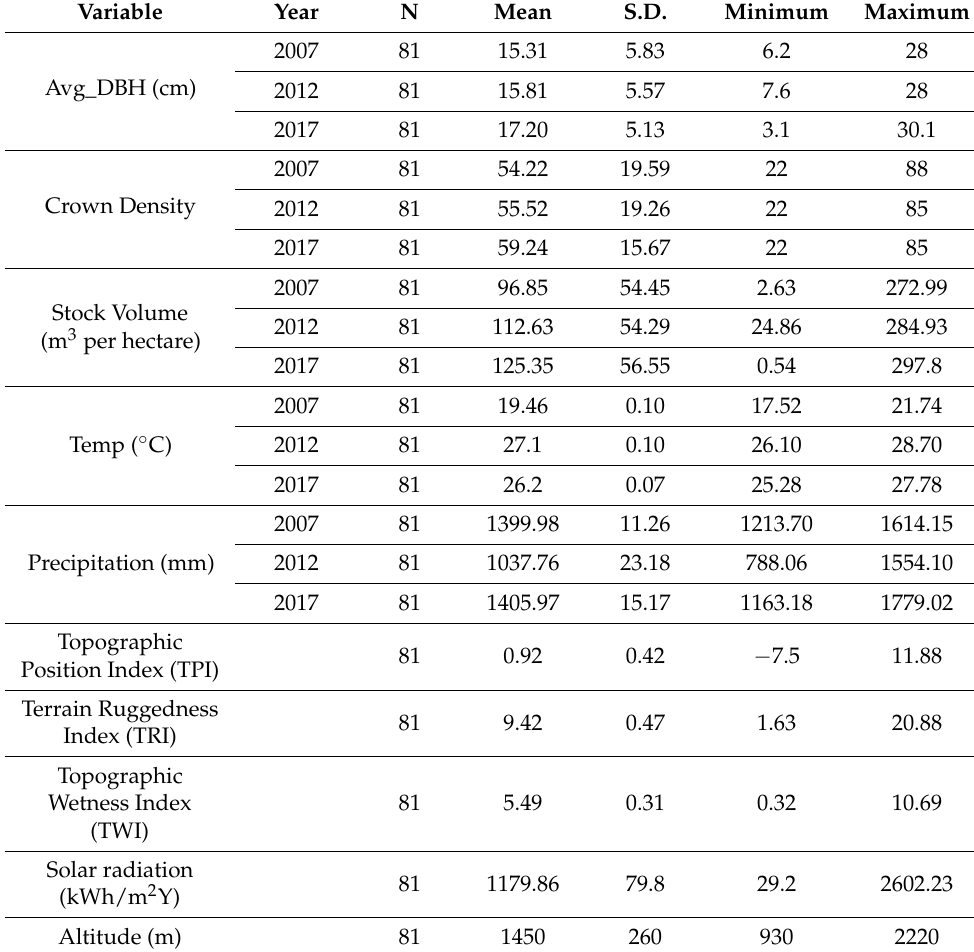
Table 1. Descriptive statistics of fitted variables used in this